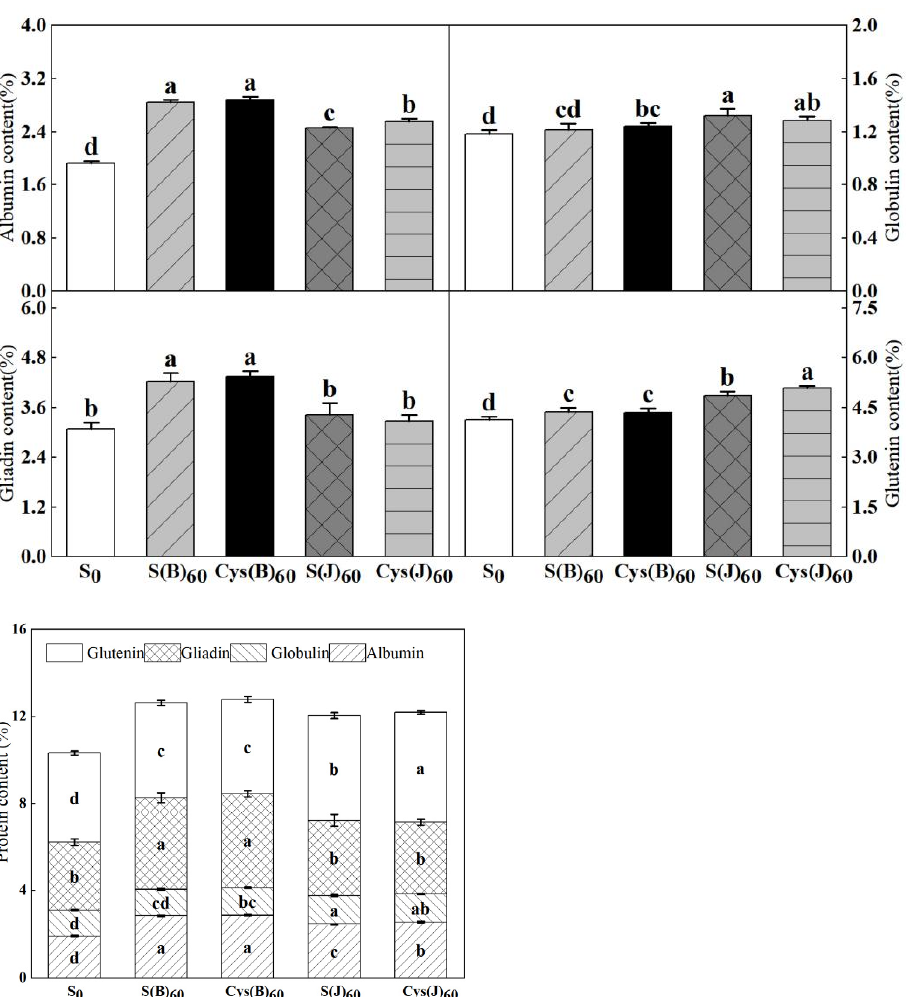
Figure 1. Effects of cysteine and inorganic sulfur at different stages on contents of protein and its components in flour. Different small letters in the same column of each treatment are significantly different at a 0.05 probability level.